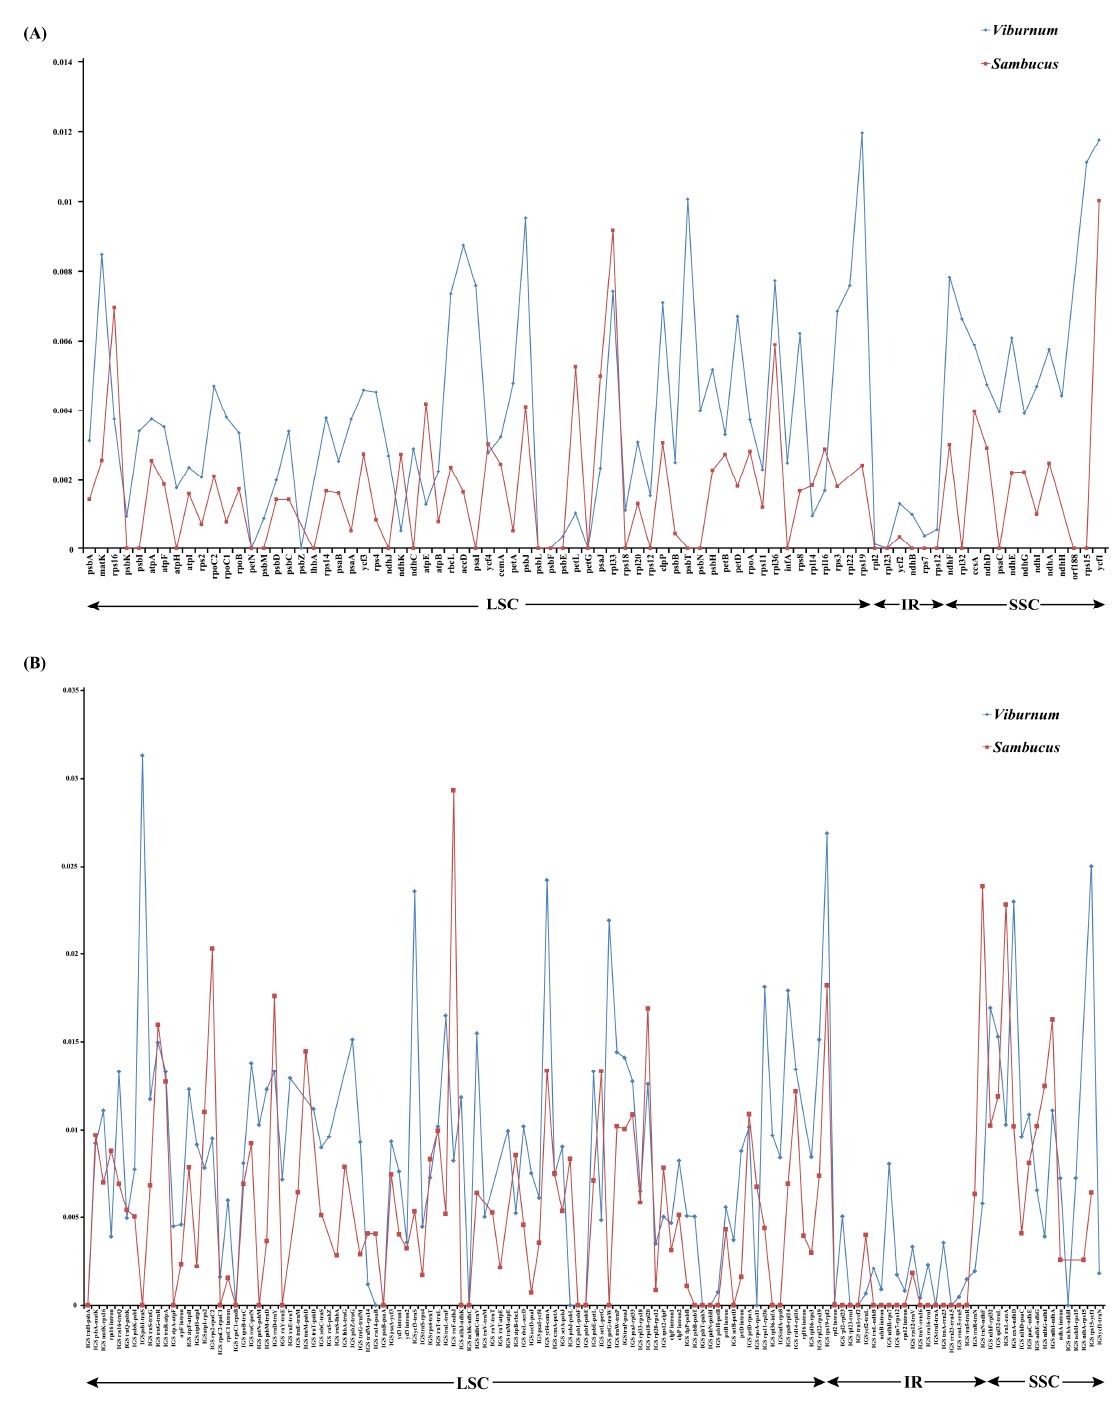
Figure 3. Percentages of variable characteristics in homologous regions among the chloroplast genomes of 24 Adoxaceae species. ( A ) Pi values among CDSs. ( B ) Pi values of intergenic spacer (IGS) regions and introns. Table 3. Pi values of the ten most variable coding and noncoding regions in Viburnum and Sambucus .